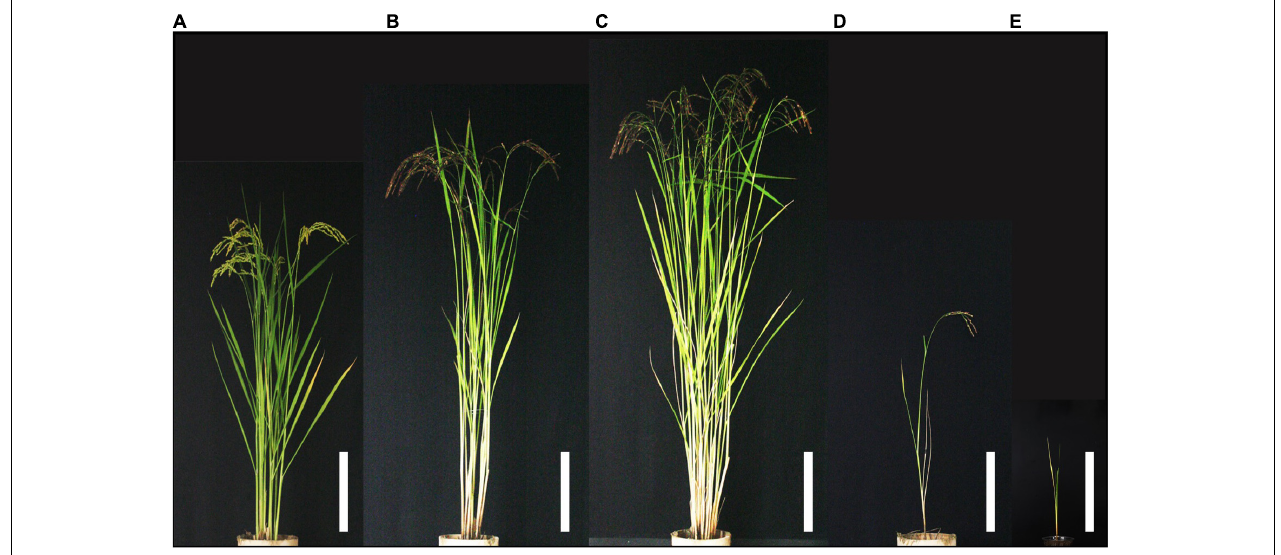
FIGURE 1 | Morphology of F 2 plants and parents at the reproductive stage. (A) T65, (B) Lijiangxintuanheigu (LTH), (C) normal plant, (D) weak plant, and (E) severe weak plant. Scale bars = 20